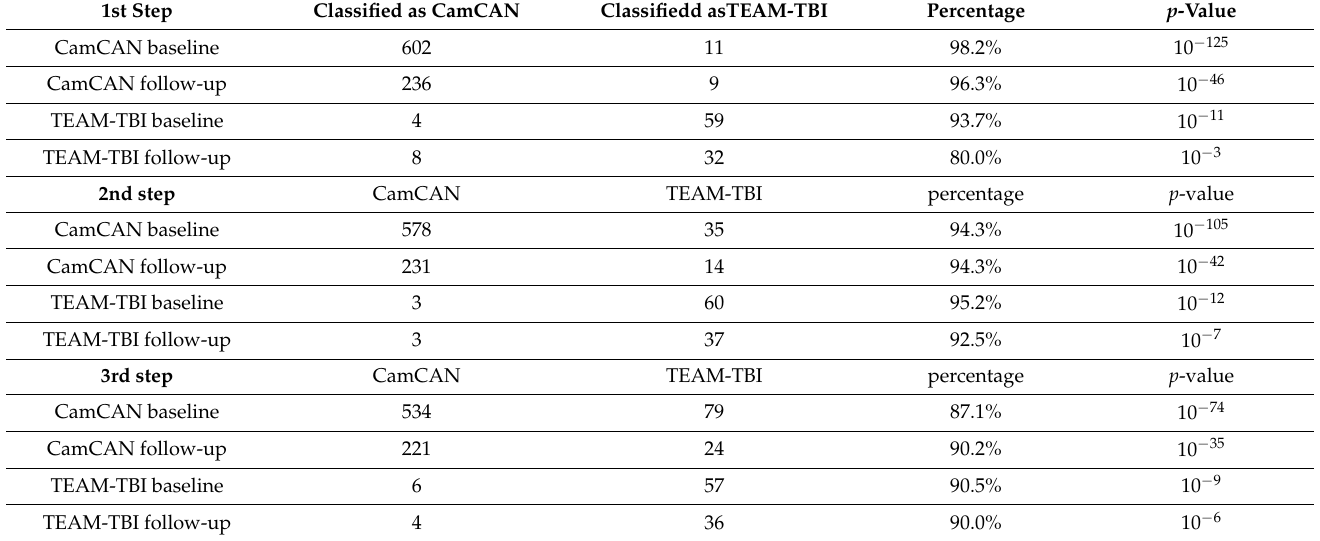
Table 5. 68 cortical and 68 adjacent white matter regional measures were trained as linear classifiers by cohort using the baseline CamCAN and TEAM-TBI measures. Jackknifed classification accuracies are shown. The results highlighted in light gray were obtained when the regions which were selected for the first classification analysis were excluded. The results highlighted in darker gray were obtained when the regions which were selected for the both the first and second classification analyses were excluded. See the text for details.